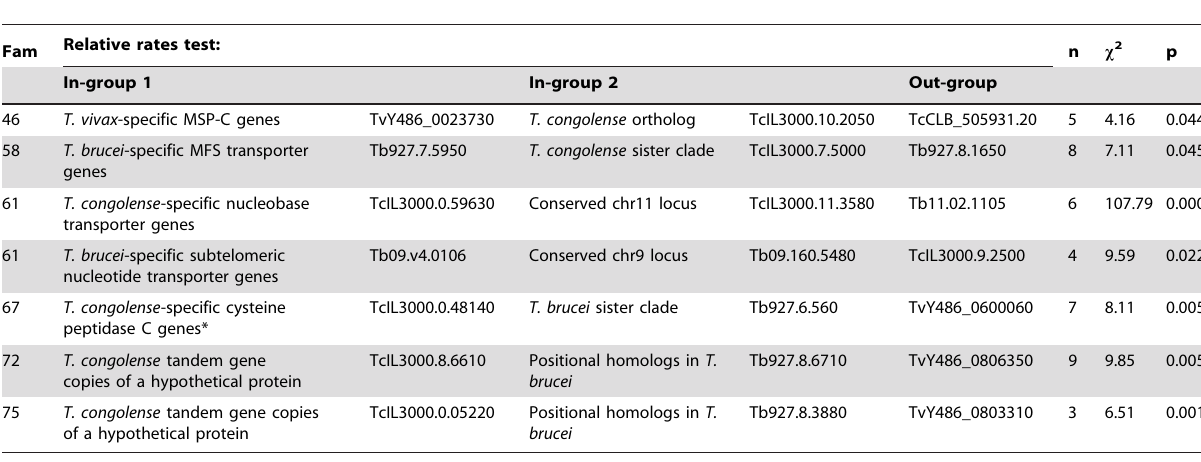
Table 1. Examples of significant substitution rate asymmetry inferred by relative rates